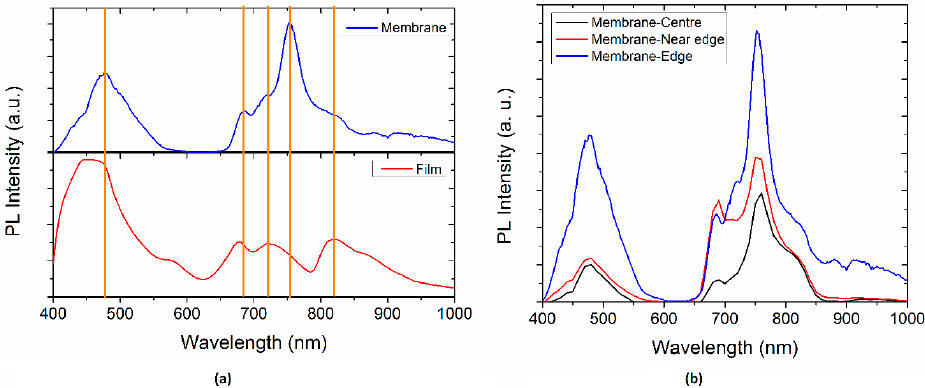
Figure 8. Photoluminescence spectra of ( a ) membrane and semiconductor film and ( b ) membrane at different positions.